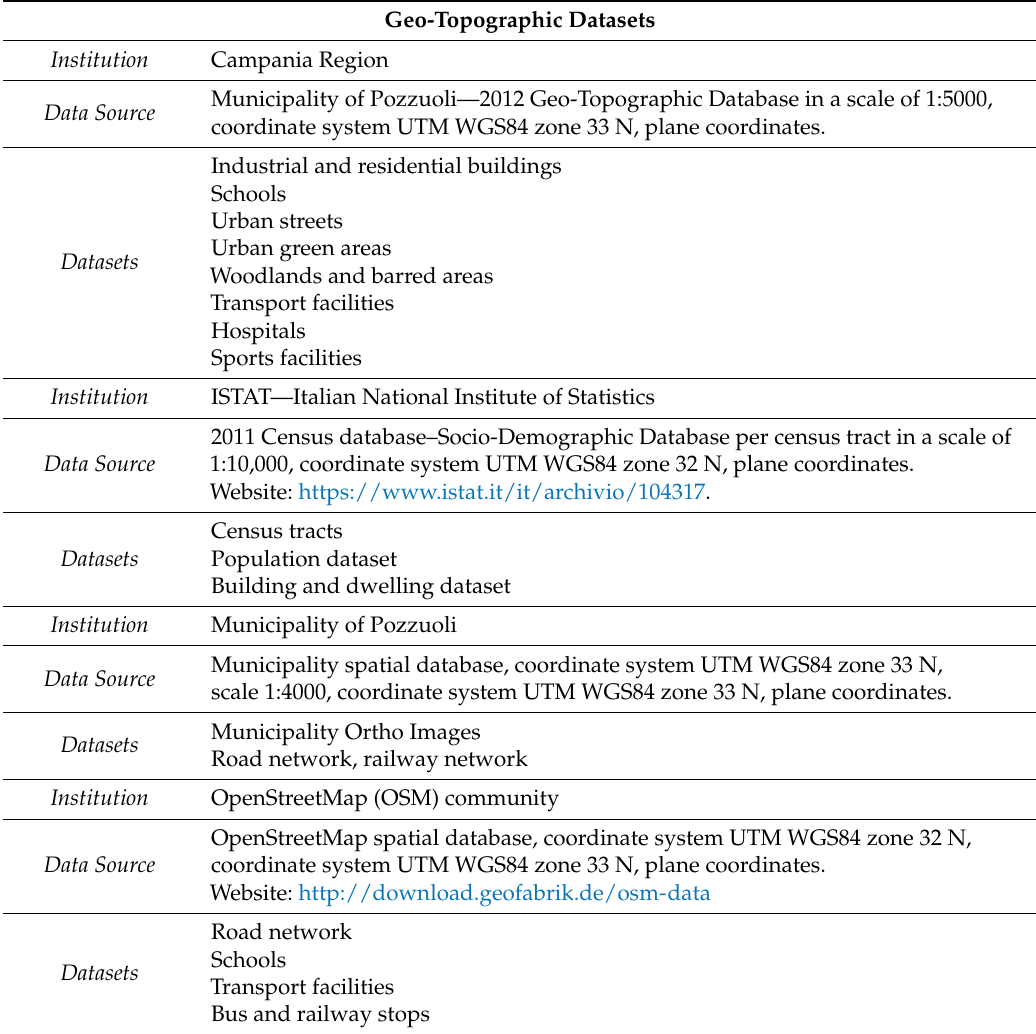
Table 6. Data sources and datasets used in the